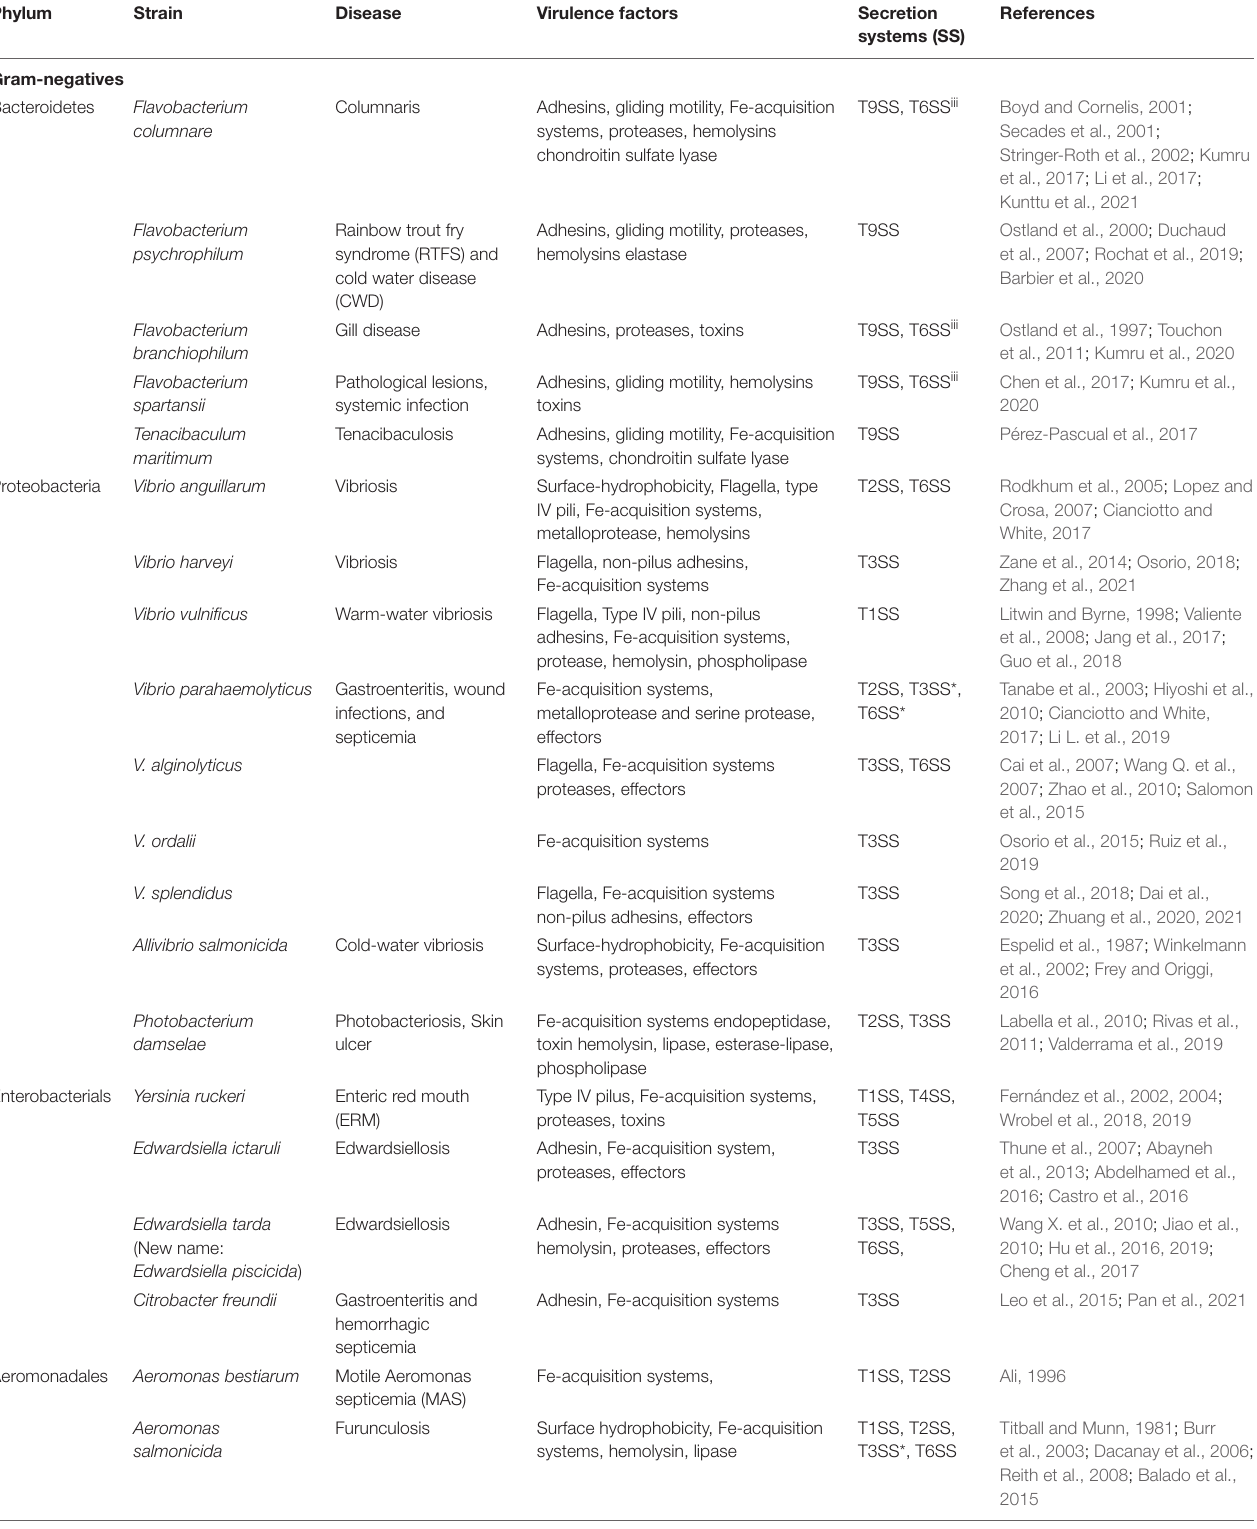
TABLE 1 | List of common Gram-negative fish pathogens, including taxonomy information, disease type, virulence factors and virulence-related secretion systems obtained from experimental and/or genomic data.